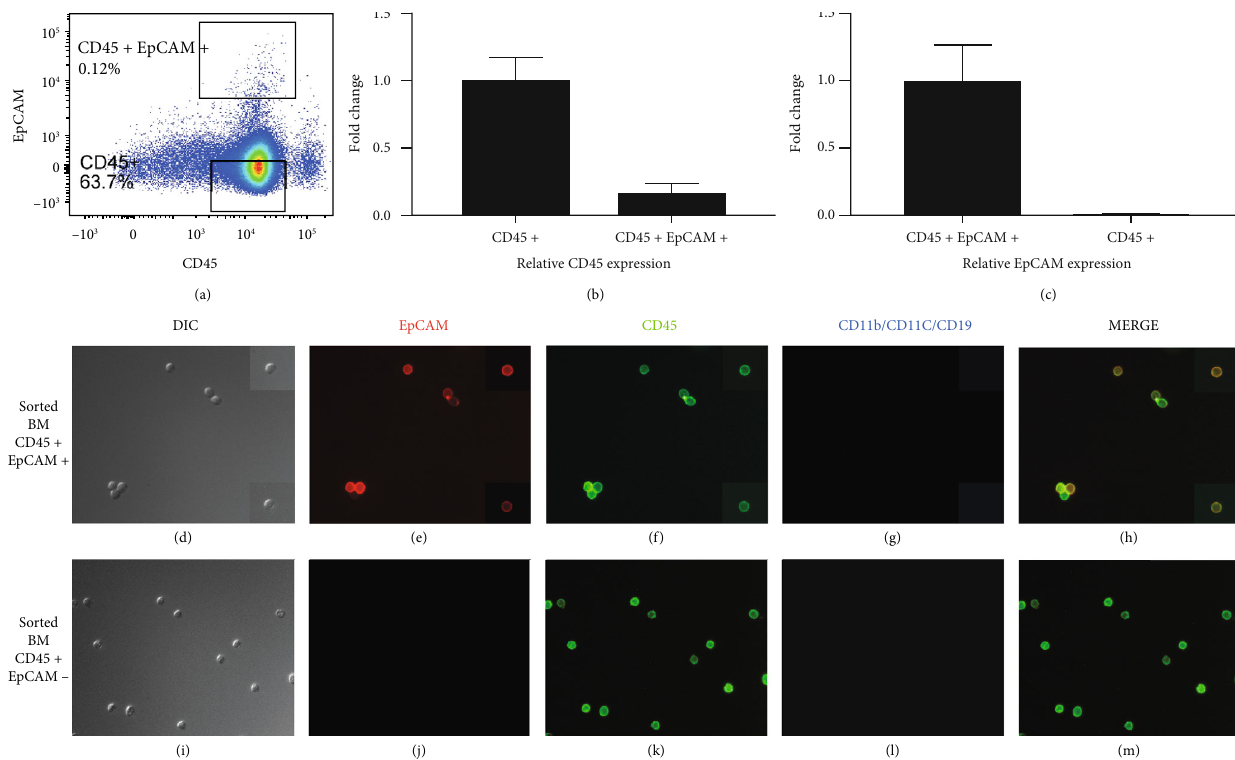
Figure 3: Single sorted bone marrow-derived CD45+ EpCAM+ cells express both the CD45 and EpCAM genes and surface proteins. CD45 + EpCAM+ cells were sorted to high purity and analyzed for CD45 and EpCAM expression using immuno fl uorescence microscopy, as well as qRT-PCR. CD45+ EpCAM- cells were also sorted as a control. (a) FACS pro fi le of the gating strategy used for sorting the CD45+ EpCAM + and CD45+ EpCAM- populations from the bone marrow subsequently analyzed for mRNA expression using qPCR and protein expression by histology. (b) Shows the relative CD45 mRNA expression level in the sorted BM-derived CD45+ EpCAM+ cells compared to the CD45+ EpCAM- control population; (c) shows the relative EpCAM mRNA expression level in the sorted BM-derived CD45+ EpCAM+ cells compared to the CD45+ EpCAM- control population. (d – h) DIC image, EpCAM staining (red), and CD45 staining (green); CD11b, CD11c, and CD19 staining (blue); and merged (CD45 and EpCAM) image, respectively, for CD45+ EpCAM+ experimental population. (i – m) DIC, EpCAM staining (red), and CD45 staining (green); CD11b, CD11c, and CD19 staining (blue); and merged (CD45 and EpCAM) images, respectively, for CD45+ EpCAM- control population. A minimum of three replicates of all experiments were